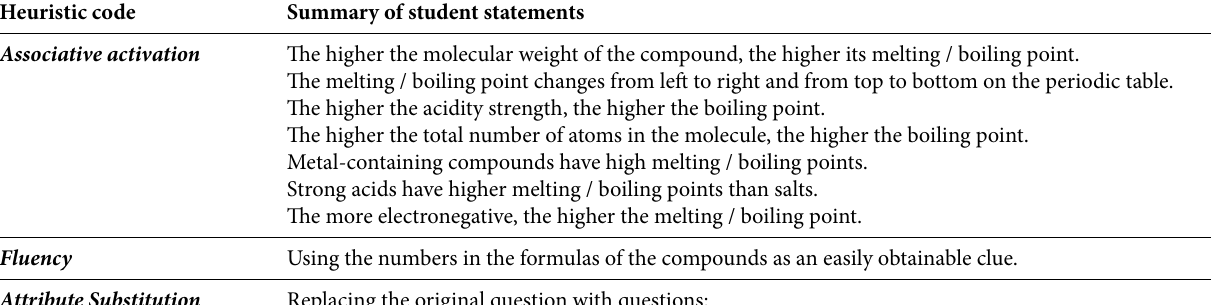
Table 2. Heuristic codes and summaries of student statements (for three